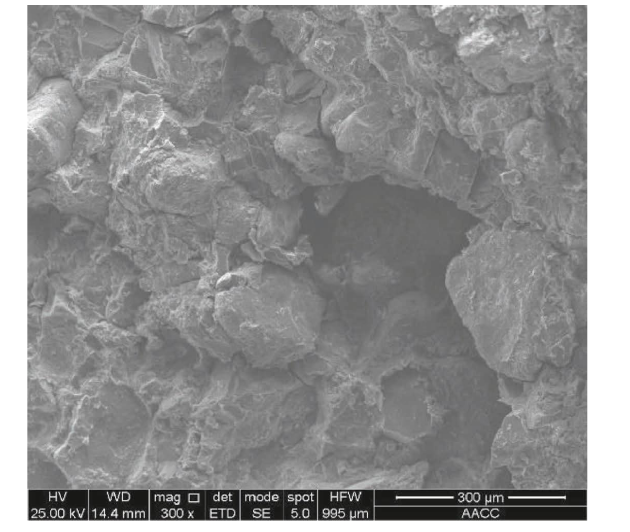
Figure 5: SEM photos of the sections of the red-sandstone specimen (when n � 40).